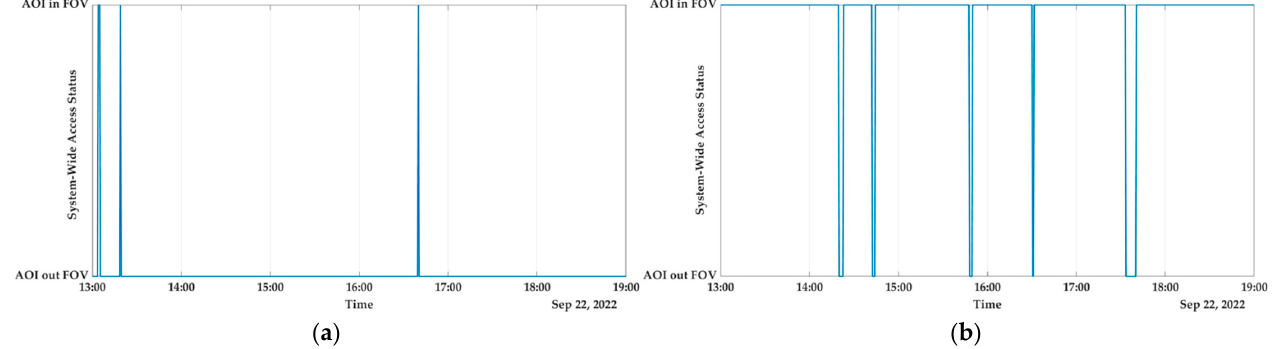
Figure 10. Australia: ( a ) system-wide access status; ( b ) system-wide access status with reconfiguration.